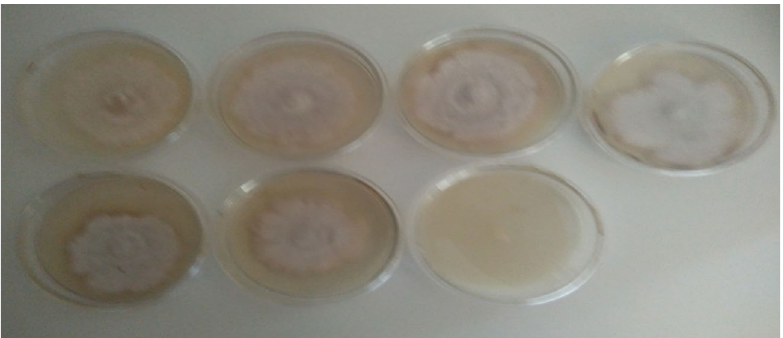
Figure 2. Pestalotiopsis species growing on PDA amended with different concentrations of wood vinegar and carbendazim at day 7. (Top row L–R; Control, 0.67, 1.34, 2.01 (%), bottom row L–R; 2.68, 3.35 and Carbendazim 0.1%).